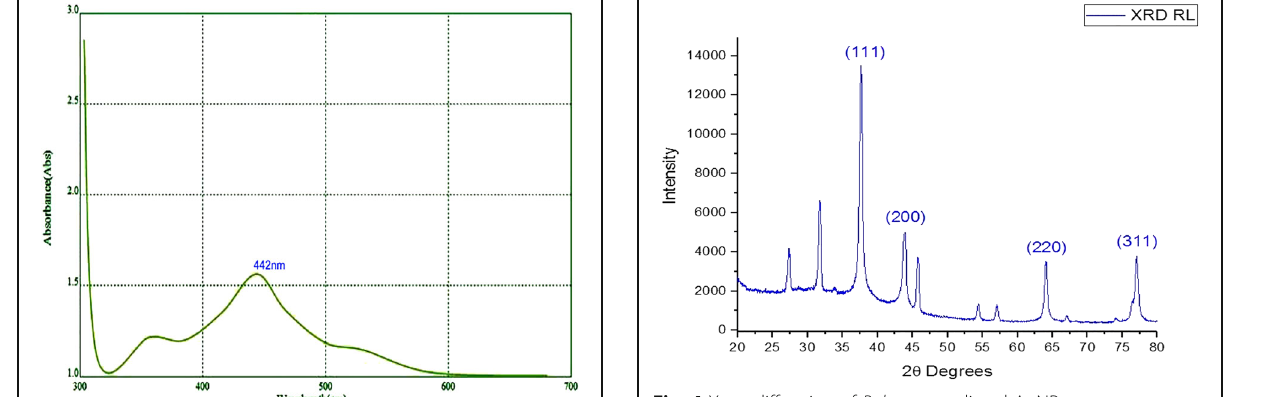
Fig. 4 X-ray diffraction of R. laetus -mediated AgNPs